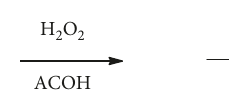
Figure 5: Degradation mechanism of